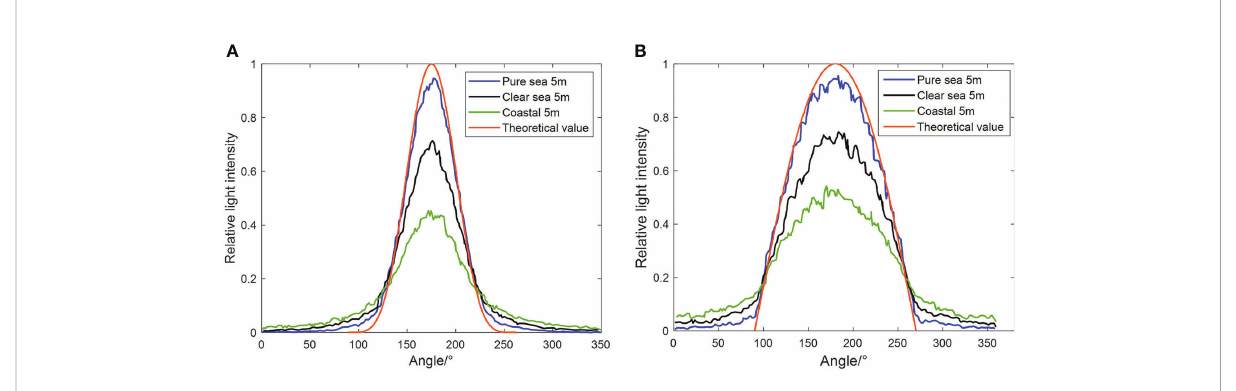
FIGURE 3 Luminous effects of single LEDs with half power angles of (A) 30° and (B)